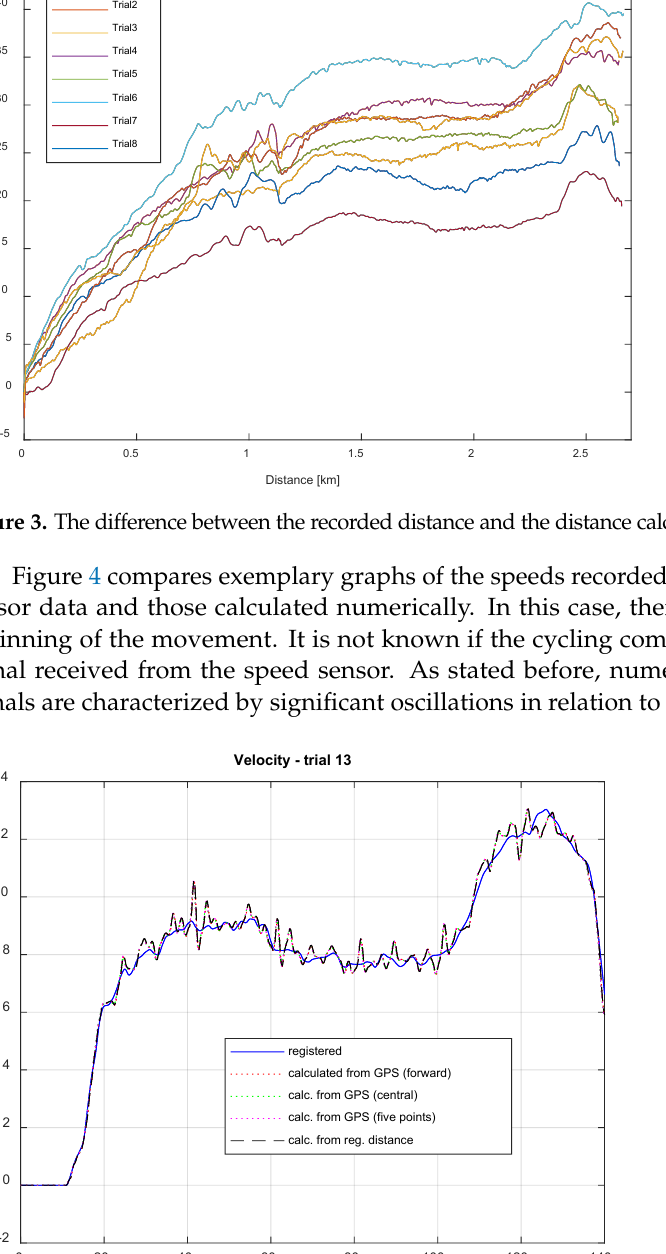
Figure 4. An example of the speed chart recorded on the basis of the speed sensor readings.